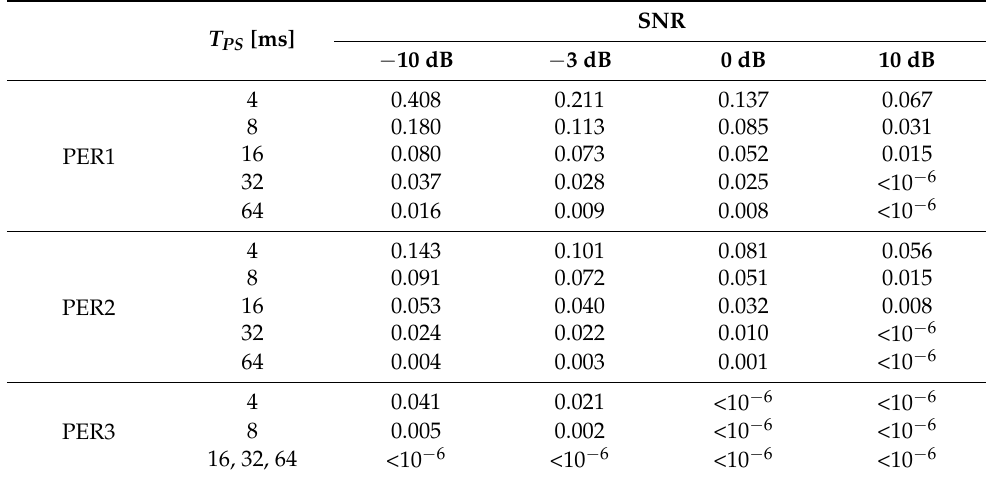
Table 6. Preamble Error Rate (PER) values for different values of T PS and SNR—channel NCS1 (Threshold 50%).